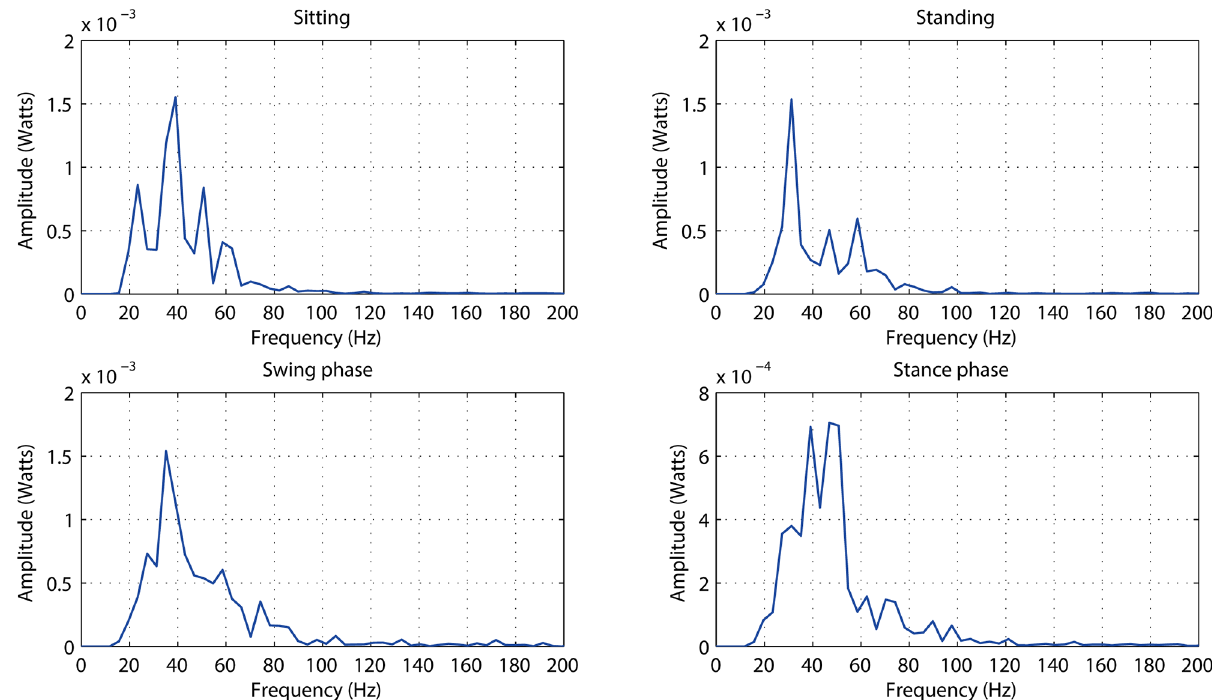
Fig 4. The PSD curves of the segmented EMG time series in terms of the swing phase, the stance phase, sitting, and standing.